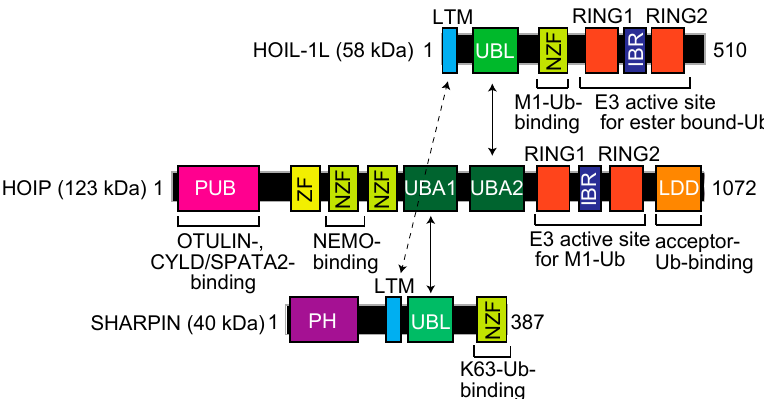
Figure 1. Domain structure and functional regions of the LUBAC subunits, HOIL-1L, HOIP, and SHARPIN. LTM, LUBAC-tethering motif; UBL, ubiquitin-like; NZF, Npl4-type zinc finger; RING, really interesting new gene; IBR, in-between RING; PUB, PNGase/UBA or UBX; ZF, zinc finger; UBA, ubiquitin-associated; LDD, linear ubiquitin chain determining domain; PH, Pleckstrin-homology.